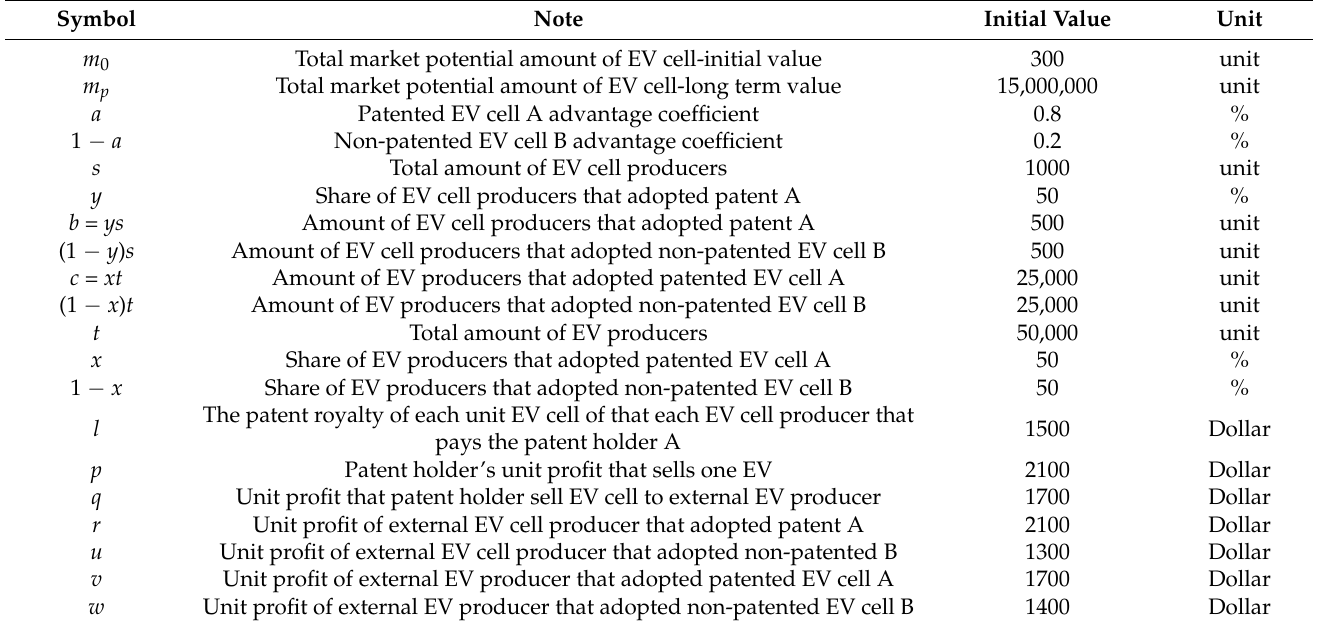
Table 3. Parameter